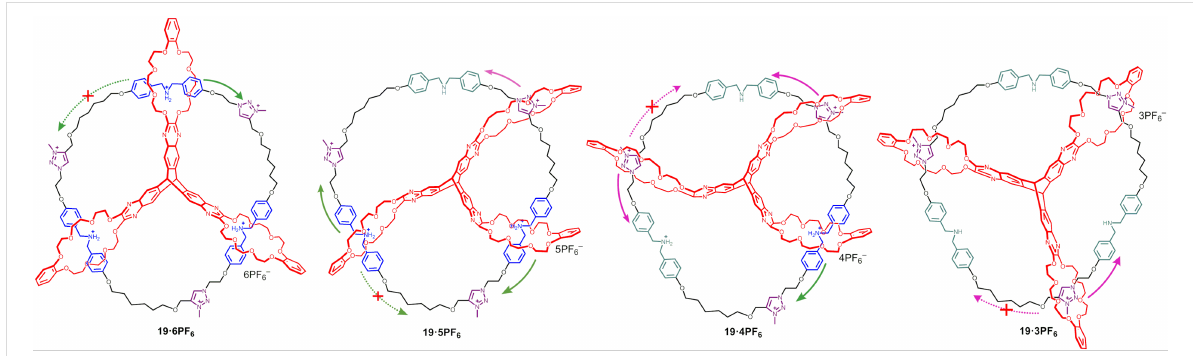
Figure 16: Chemical structure of compound 19 and acid–base triggered